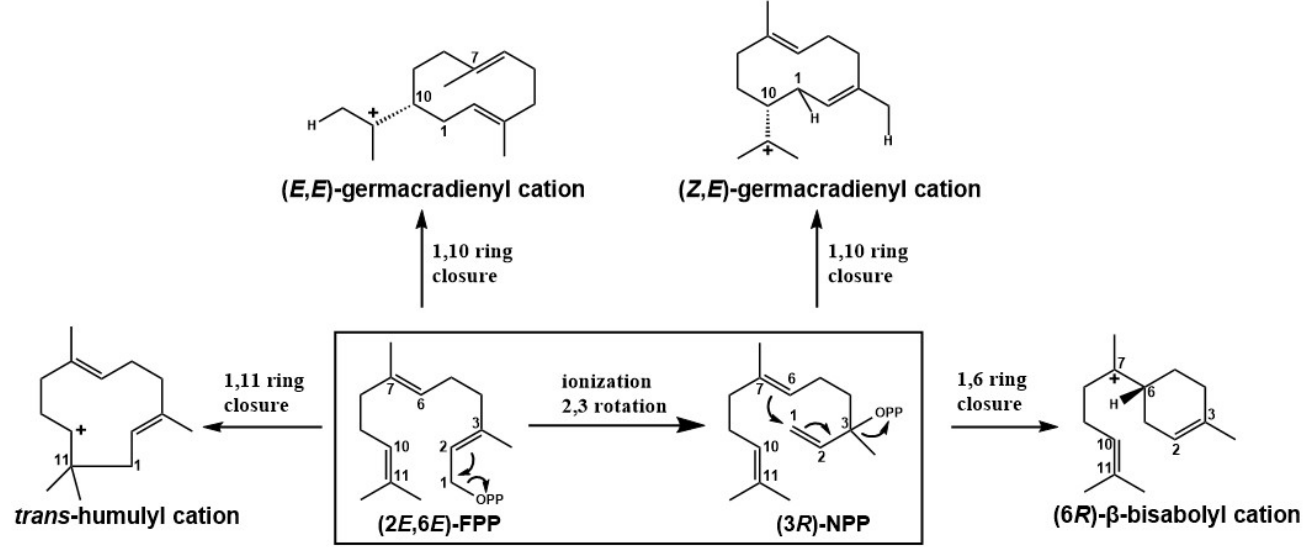
Figure 2. Cyclization patterns of sesquiterpenes in basidiomycetes.